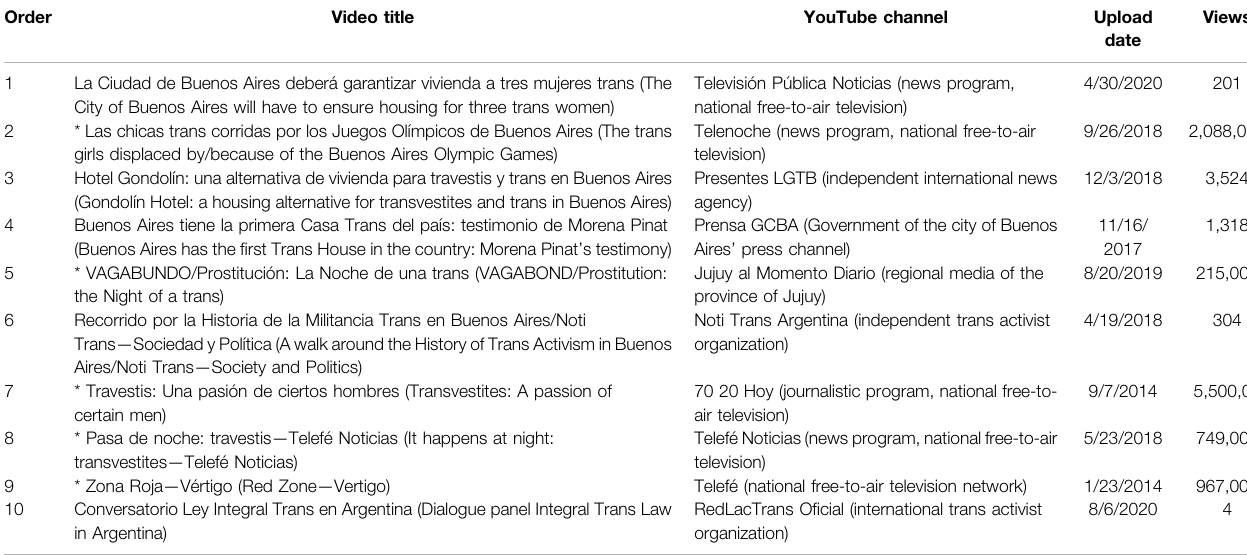
TABLE 2 | First ten results of the YouTube search “ trans + city + Buenos Aires ” (August 6, 2020).